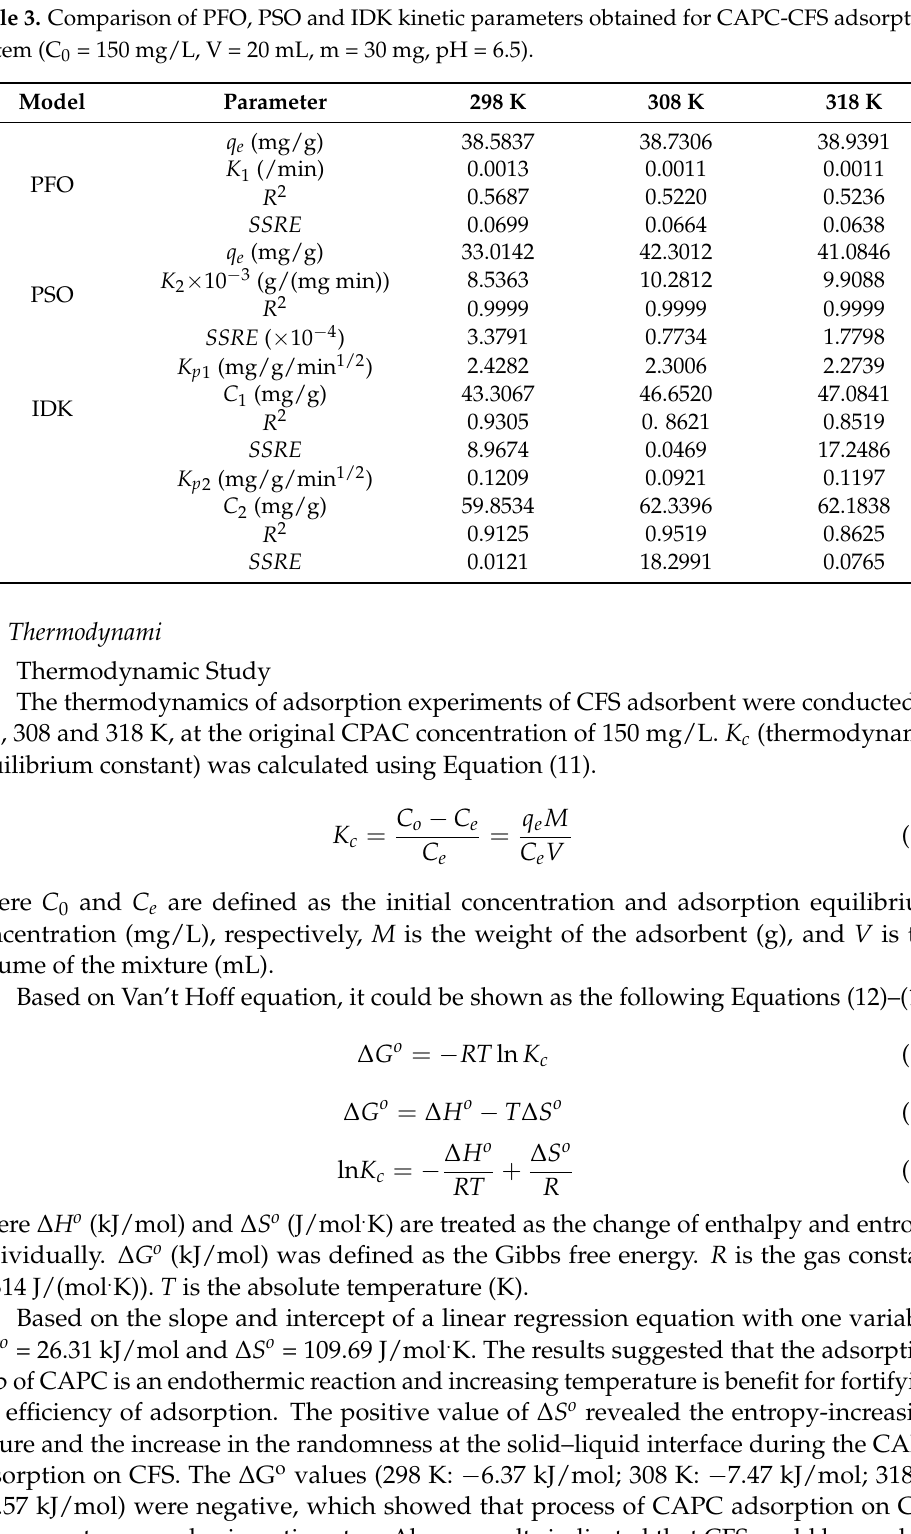
Table 3. Comparison of PFO, PSO and IDK kinetic parameters obtained for CAPC-CFS